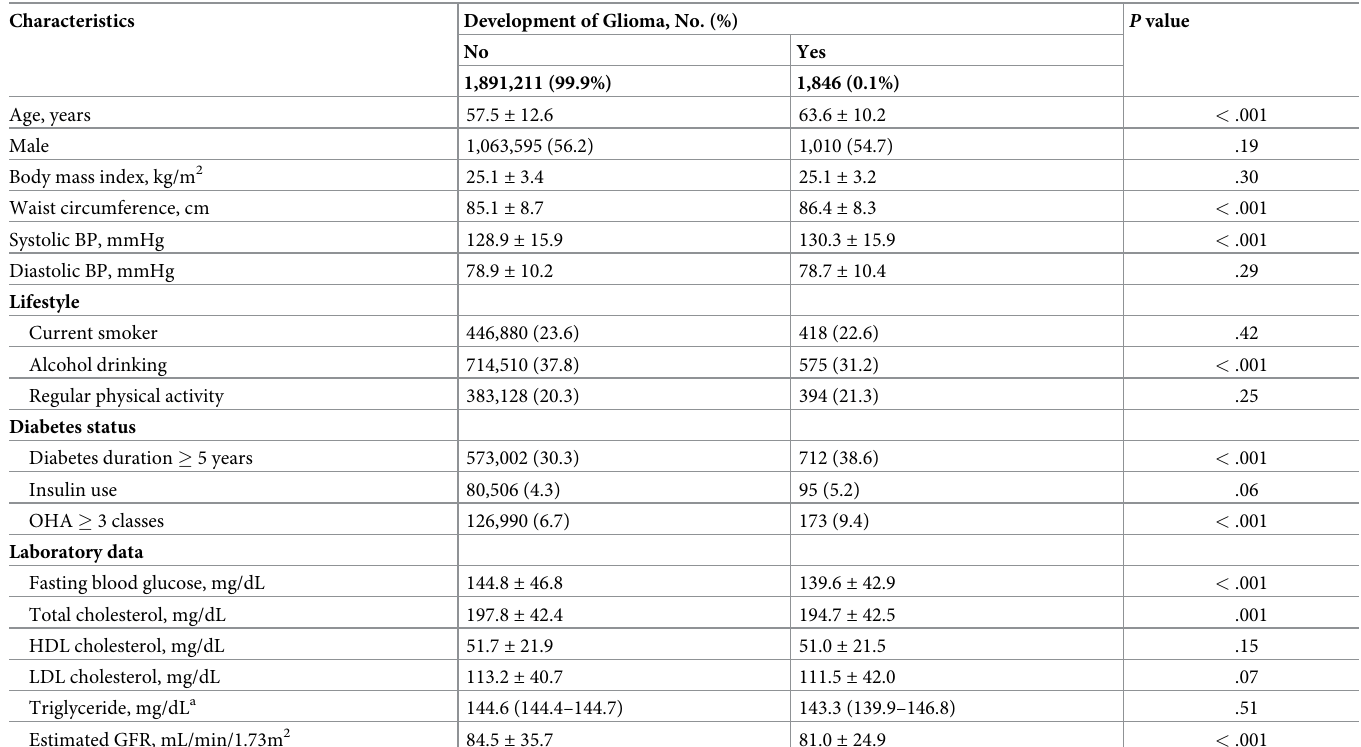
Table 1. Baseline characteristics of the study population.